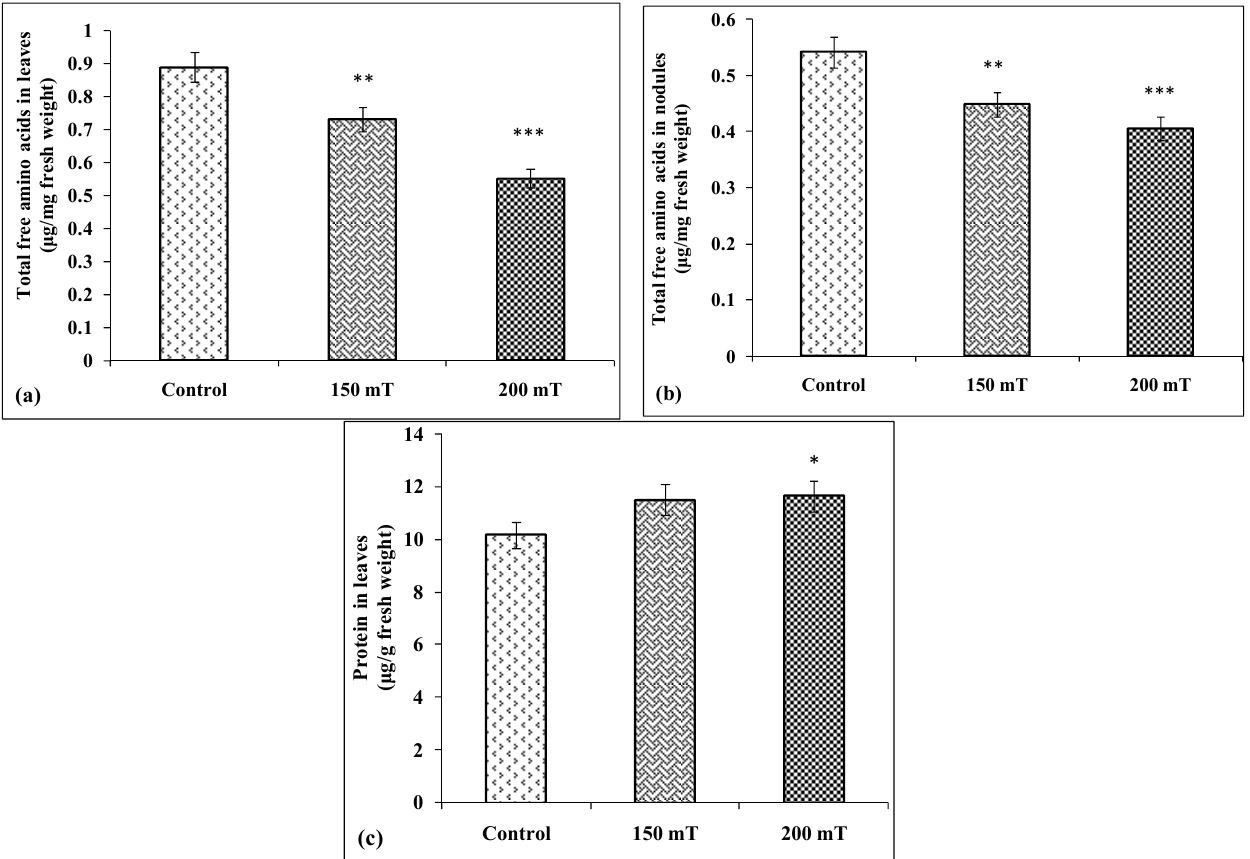
Figure 18. Effect of pre-sowing exposure of soybean seeds to magnetic field on total free amino acids in leaves ( a ), nodules ( b ), and protein content of leaves ( c ). ***, ** and * indicate significance at p < 0.001, 0.01 and 0.05, respectively, compared to